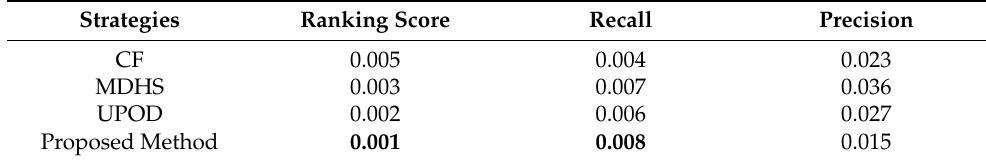
Table 6. σ comparison with other methods [23–27,32,33]. Table 6. 𝜎 comparison with other methods [23–27,32,33]